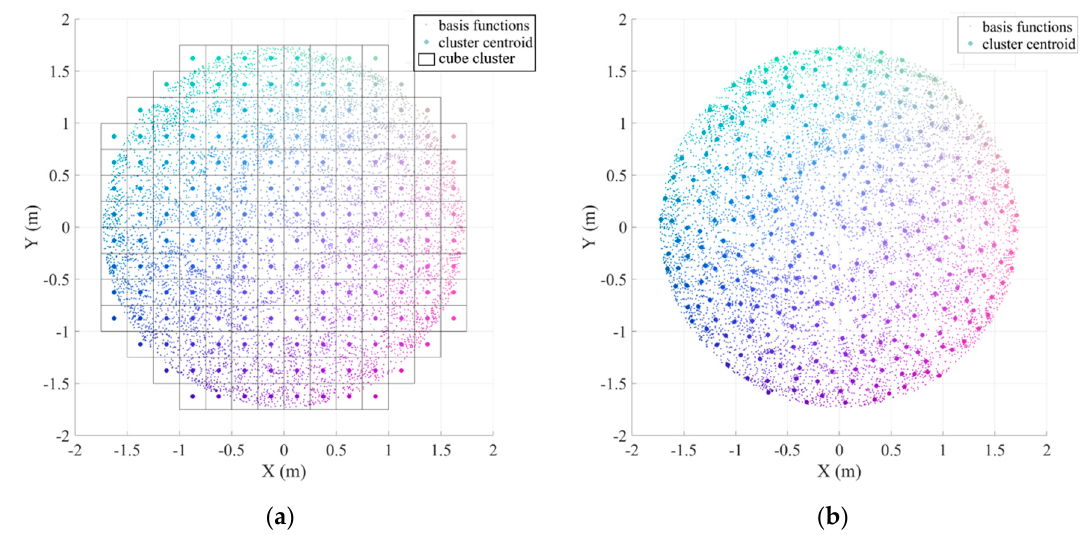
Figure 2. Sliced top view of basis functions and clusters in the canonical sphere CAD model: ( a ) conventional cube grouping; ( b ) proposed K-means clustering.